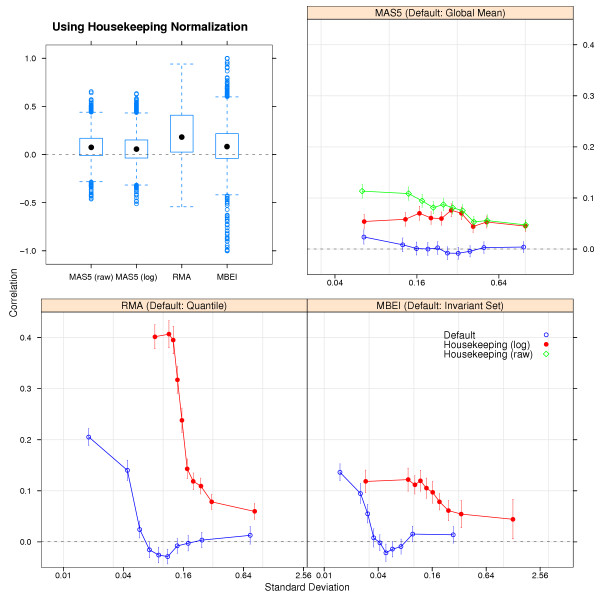
Correlations for the Breast Cancer data set normalized using a predefined set of 100 houskeeping genes. The MAS5 expression values were normalized both before and after taking the logarithm, corresponding to MAS5 (raw) and MAS5 (log). The RMA and MBEI expression values were normalized after caculating the logarithmized expression values, see Methods. Top left: The distributions of the correlation coeffcients are not centered at zero. Top right and bottom: Mean correlations versus median product of standard deviations are shown as in Figure 2, comparing the residual correlation for the housekeeping normalization and the default procedure for each expression measure (as indicated in the legends). Housekeeping normalization does much worse than the default in removing the systematic relationships. In case of the MAS5 values, both variants do worse than the default, and the normalization of the raw (un-logged) values doing worse than that of the logarithmized values.